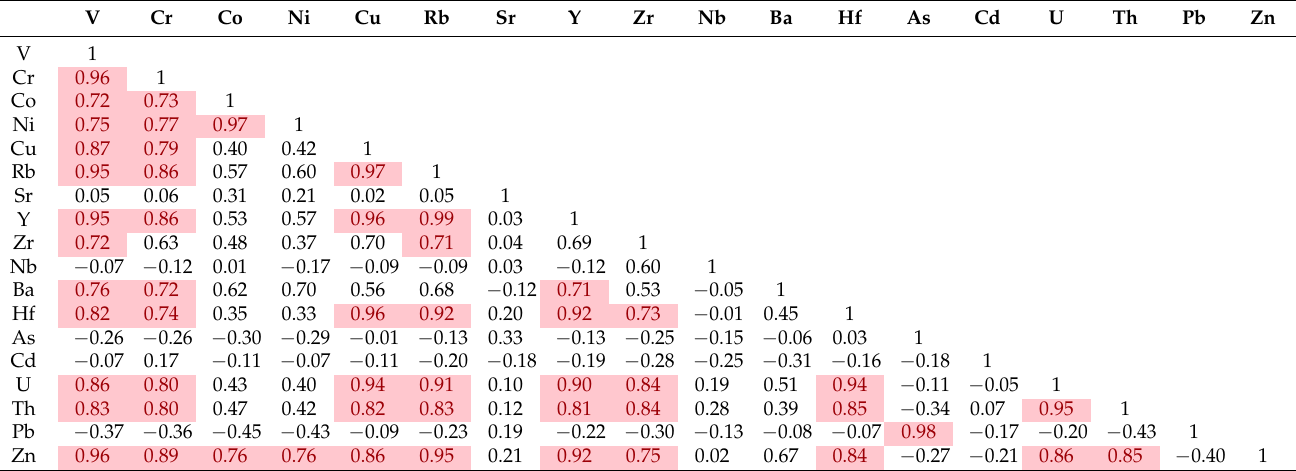
Table 4. Correlation coefficients (R) between trace elements from the stromatolites from the Lake Salda.